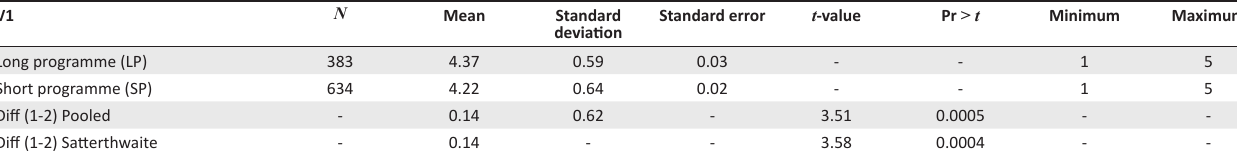
Standard error deviation